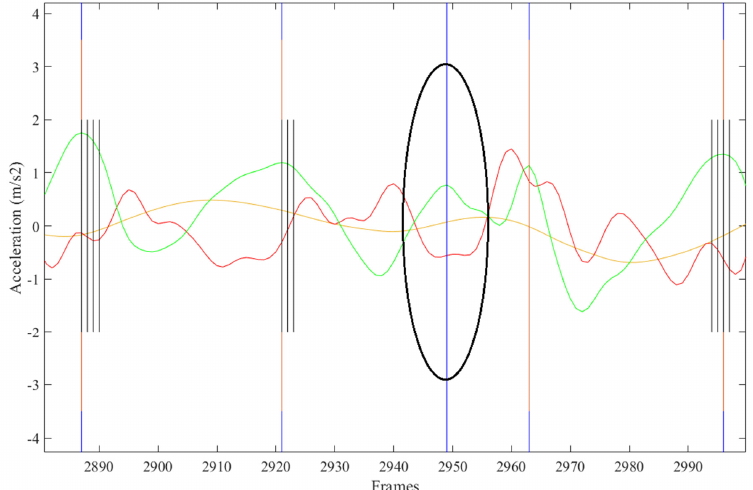
Sensors 2021 , 21 , x FOR PEER REVIEW Figure 6. Manually labelled FS not identified by AI model. Figure 6. Manually labelled FS not identified by AI model. Figure 6. Manually labelled FS not identified by AI model.